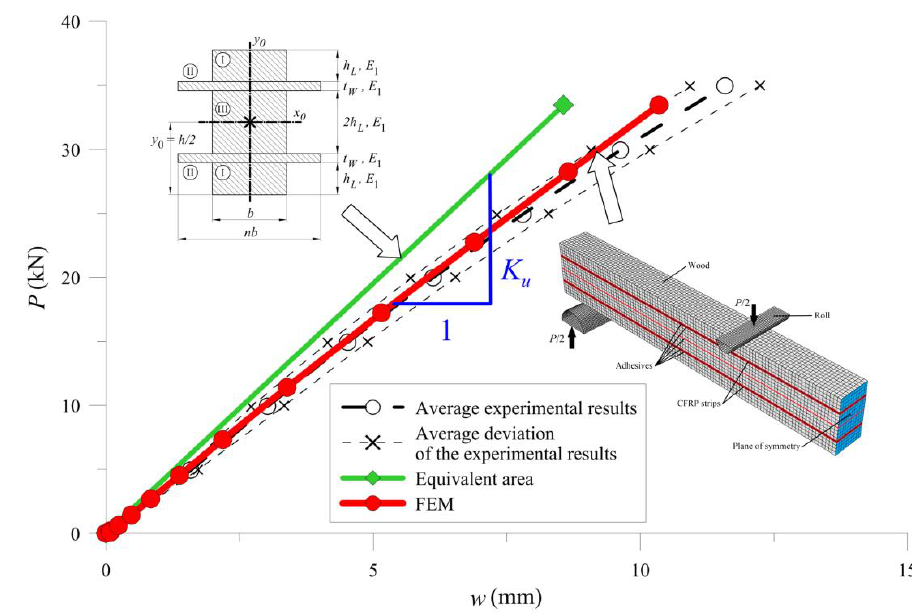
Figure 27. Results for BWW-type of the sample.